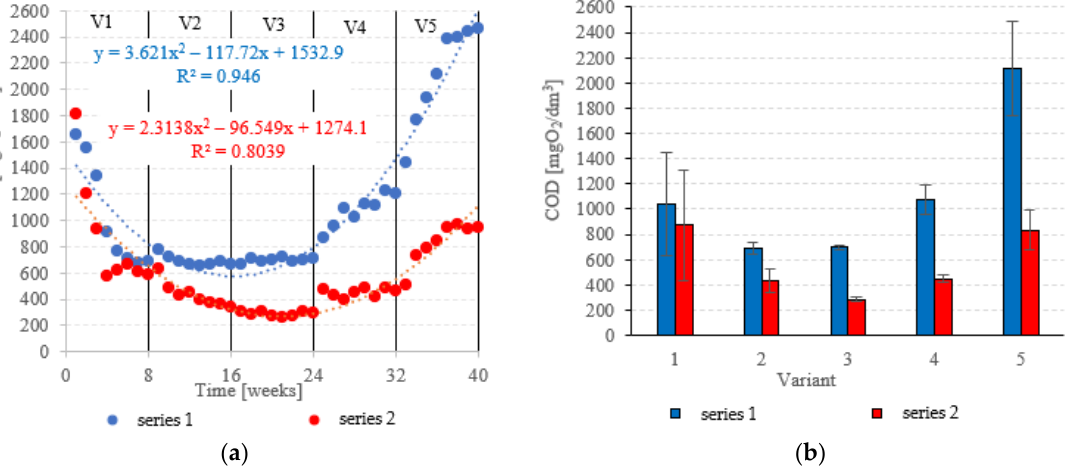
Figure 7. COD in the treated effluent (( a ) throughout the experiment; ( b ) average across experi- mental variants).